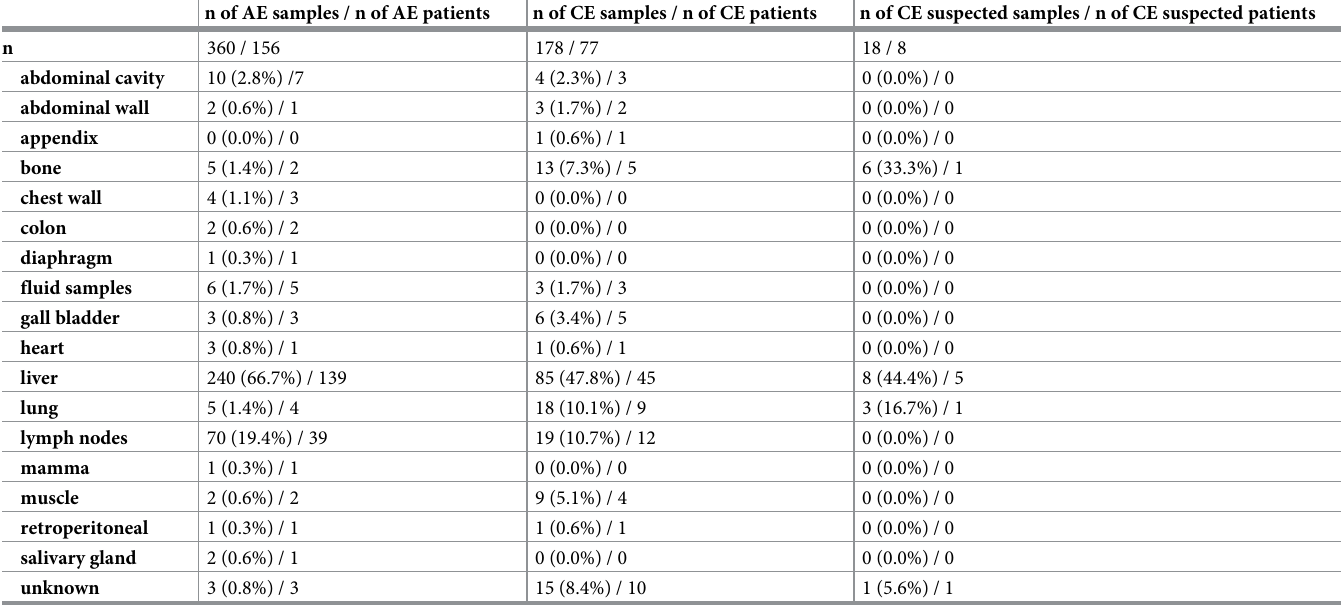
Table 1. Topographic localization of samples of patients with alveolar (AE) or cystic echinococcosis (CE). n of AE samples / n of AE patients n of CE samples / n of CE patients n of CE suspected samples / n of CE suspected